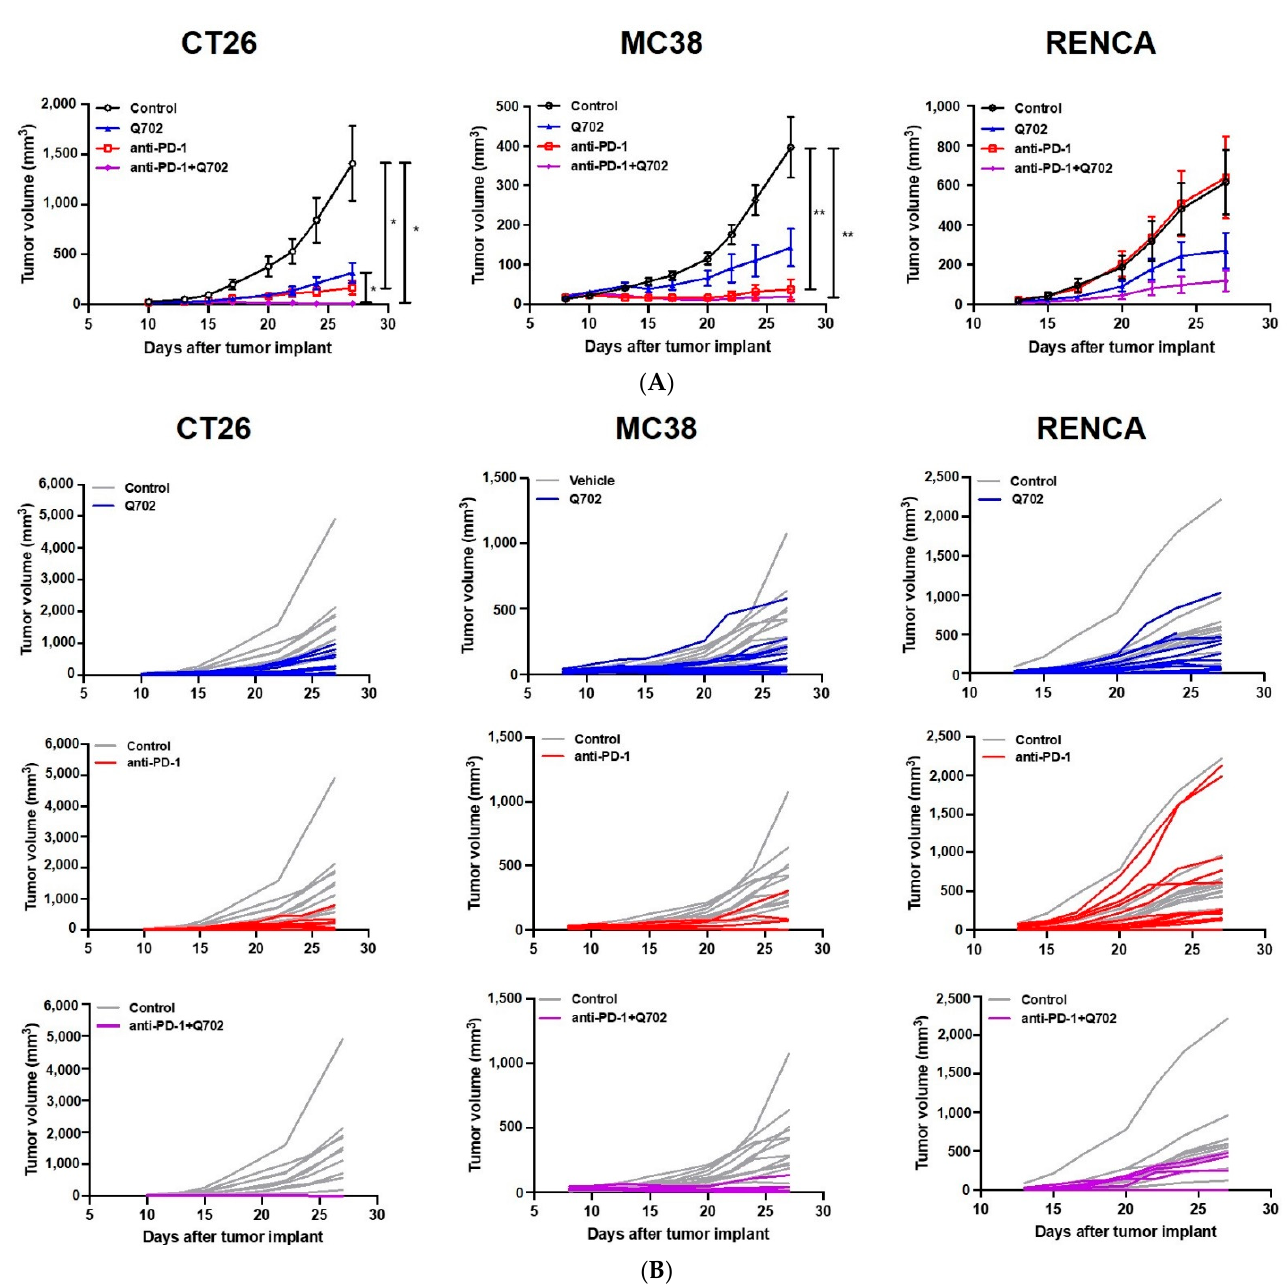
Figure 8. Combination treatment with Q702 and anti-PD-1 antibody enhances tumor growth inhi- bition in various syngeneic mouse tumor models. ( A ) RENCA mouse renal adenocarcinoma cells (1 × 10 6 ) were inoculated subcutaneously into BALB/c mice. CT26 mouse colon carcinoma cells (1 × 10 5 ) were implanted into BALB/c mice. MC38 mouse colon adenocarcinoma cells (3 × 10 5 ) were inoculated subcutaneously into C57BL/6 mice. Mice (N = 10/group) were randomized one day after tumor implantation and treated with either vehicle, anti-PD-1 (10 mg/kg, intraperitoneally twice a week), Q702 (30 mg/kg, orally once daily), or a combination of anti-PD-1 antibody and Q702. Tumor growth inhibition data are presented as mean ± SEM. * p < 0.05, ** p < 0.01, one-way ANOVA. ( B ) Graphs show the tumor growth in individual mice in each treatment